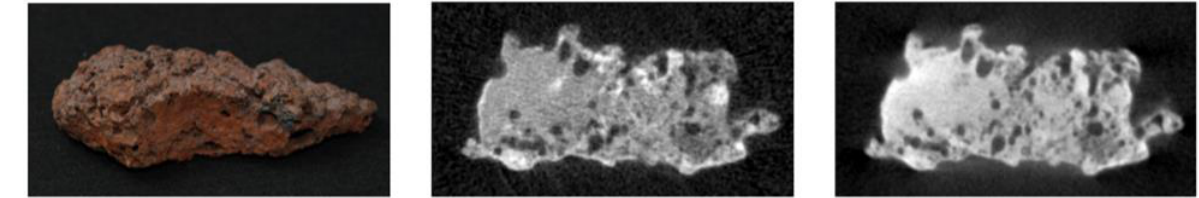
Figure 12. Sample of bog ore (from left to right ): photograph, section from neutron tomography, corresponding section from X-ray tomography (Adapted with permission from ref. [25], Copyright John Wiley and Sons, 2010). The sample dimensions are approximately 30 mm × 50 mm × 100 mm.